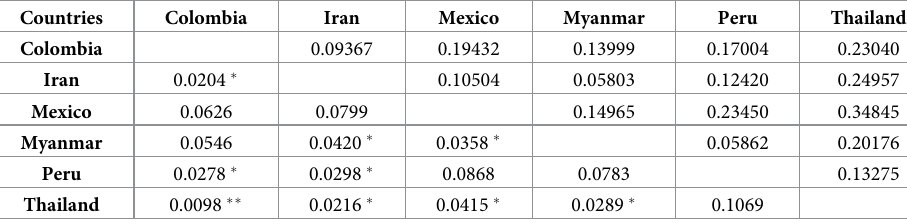
F ST values are shown in the upper right quadrant, and P values are shown in the lower left quadrant. F ST is a measure of genetic distances between populations ( � , 0.01 < P < 0.05; �� , 0.001 < P < 0.01).